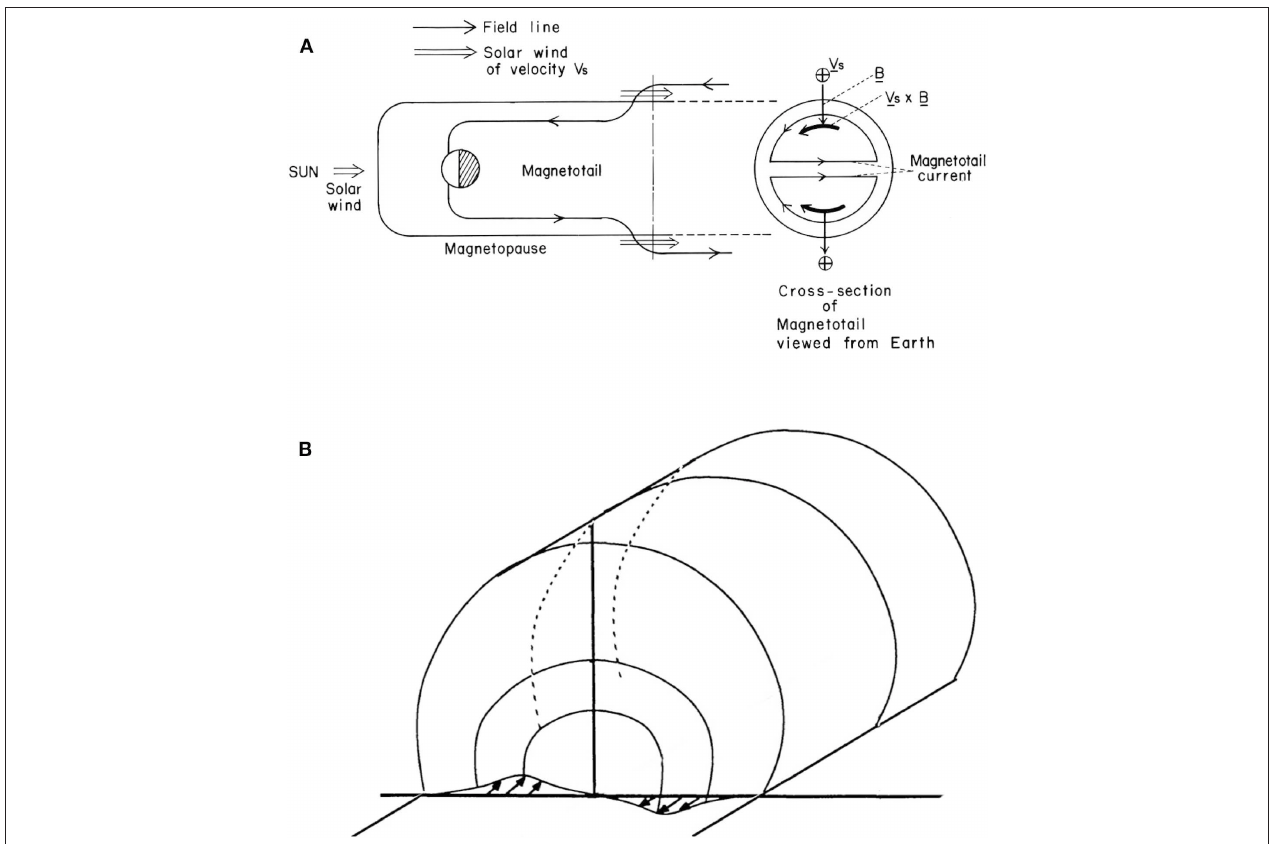
FIGURE 2 | (A) The solar wind–magnetosphere dynamo. The electromotive force ( V × B ) is generated along the northern and southern boundaries of the magnetosphere, producing two half-solenoidal currents; the cross section of the magnetosphere with the dynamo process is indicated (Akasofu). (B) A photospheric dynamo proposed by Lee et al. (1995); the photospheric plasma flows along the neutral line under a magnetic